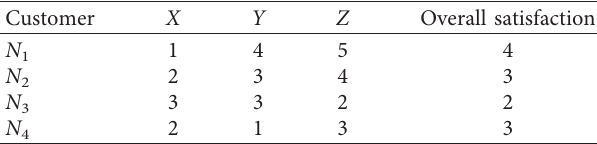
Table 2: The customer satisfaction dataset for four customers ( N N 2 , N 3 , and N 4 ). Three attributes ( X , Y , and Z ) are considered. The attribute-level performance corresponding to each attribute and overall satisfaction can take values in a scale of